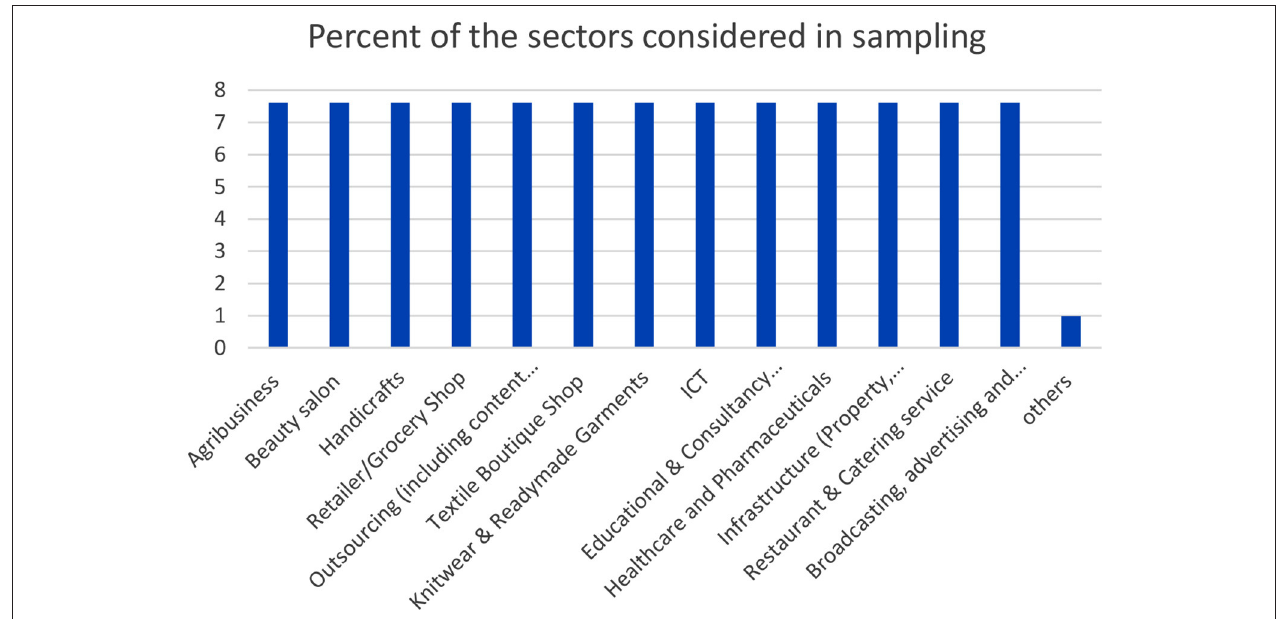
FIGURE 3 | Frequency of the sectors considered in sampling.